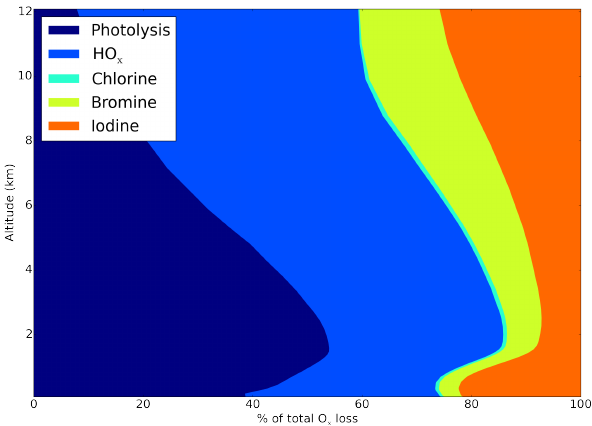
Figure 15. Global annual-average tropospheric vertical odd oxygen loss (O x ) through different reaction routes (Photolysis, HO x , IO x , BrO x , and ClO x